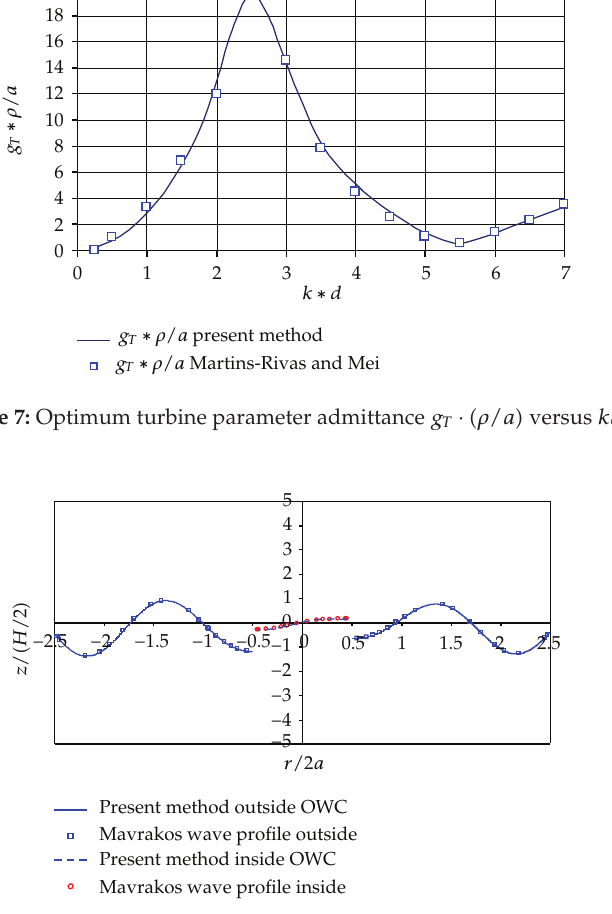
Figure 8: Wave profile inside and outside OWC device for a wave period T (cid:8) 6 . 3s.